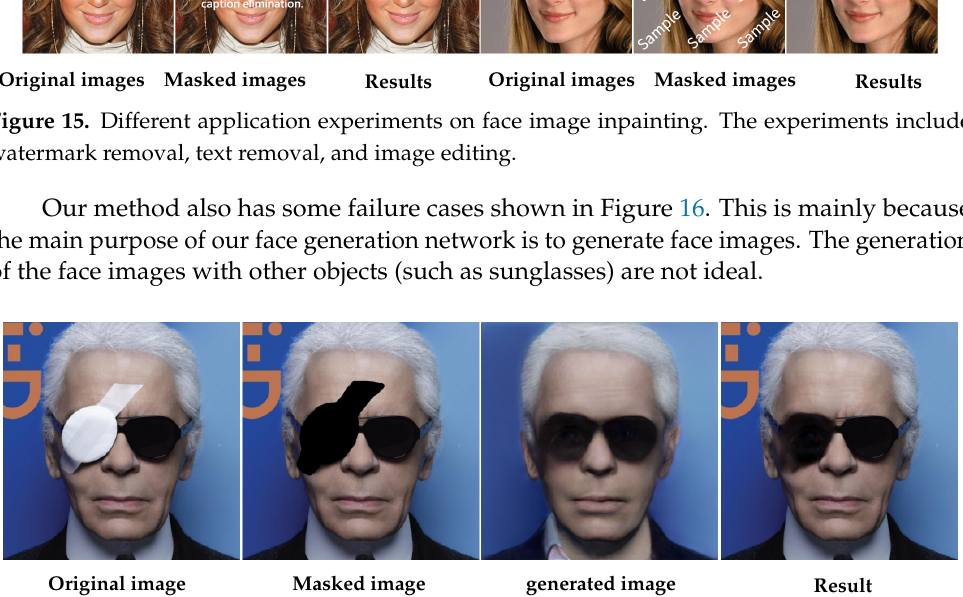
Figure 16. An example of a failed face image